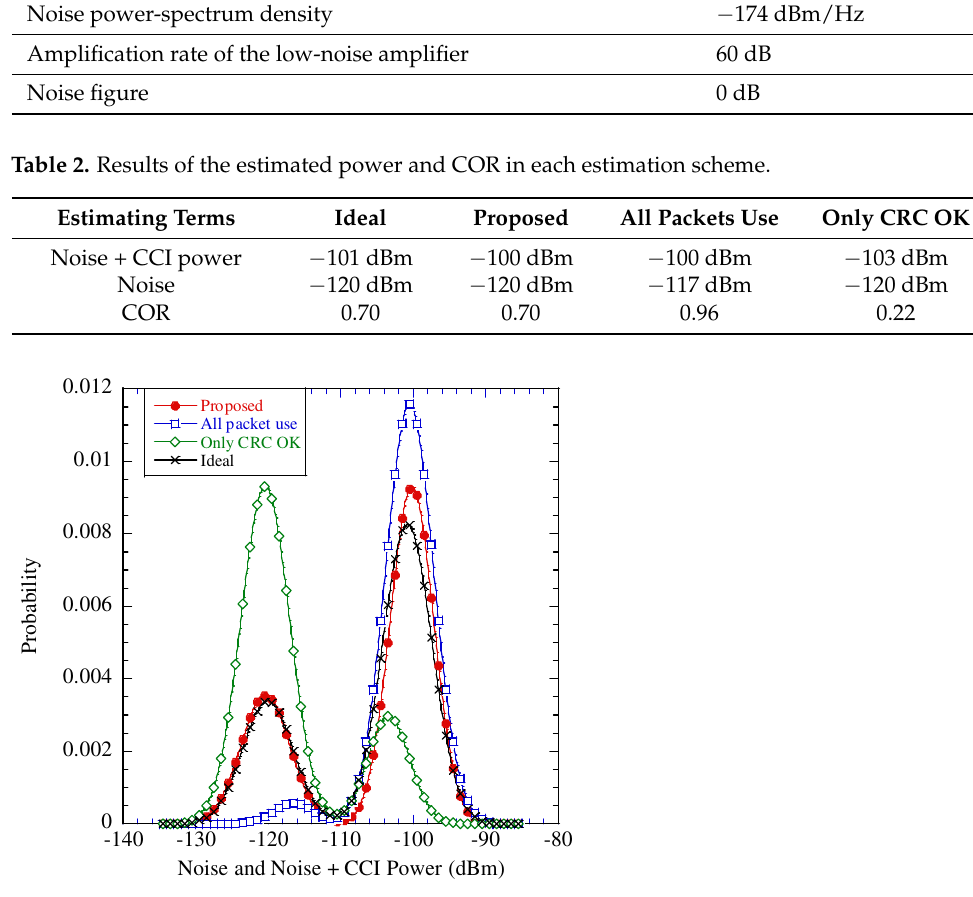
Figure 6. Example of estimating noise and CCI plus the noise power distribution in each estimation scheme and